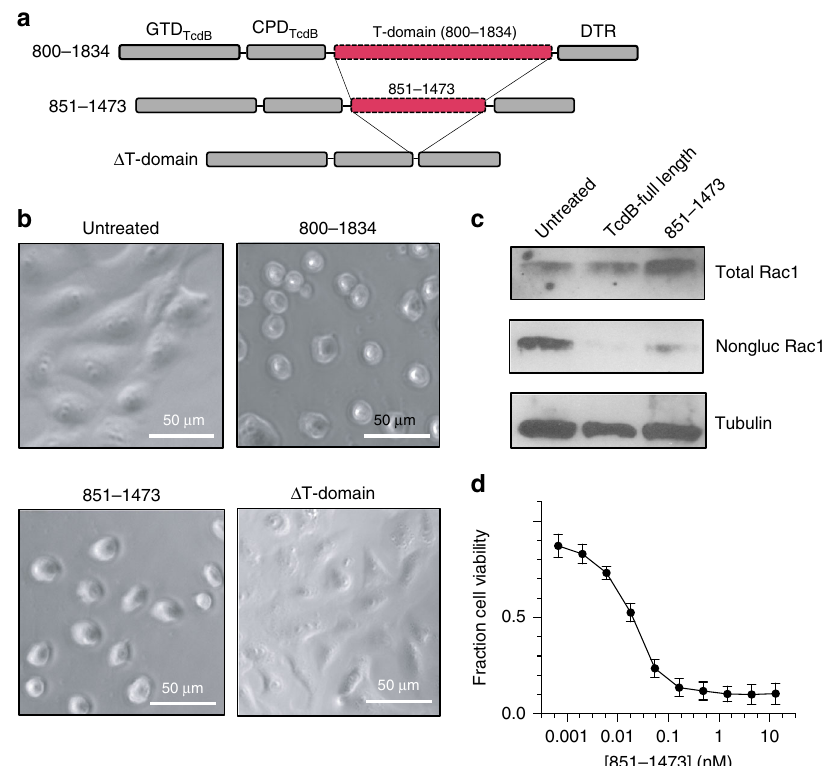
Fig. 6 TcdB 851-1473 functions as a translocase in a hybrid TcdB-DT context. a Construct design of GTD-CPD-[TcdB(800 – 1834)]-DTR (800 – 1834), GTD-CPD-[TcdB(851 – 1473)]-DTR (851 – 1473) and GTD-CPD-DTR ( Δ T-domain). b Light microscopy images of Vero cells with no toxin (untreated), 800 – 1834, 851 – 1473 or Δ T-domain after 3 h. All proteins were added to cells at a fi nal concentration of 1 nM. c Western blot to detect total Rac1, non- glucosylated Rac1 in untreated Vero cells, and in cells treated with TcdB or 851 – 1473. All proteins were added to cells at a fi nal concentration of 1 nM. d Fraction cell viability of Vero cells incubated with 851 – 1473, with 1.0 indicating 100% viable cells and 0 indicating 0% viable cells. N = 4 for all experiments. Source data are provided as a Source Data File for Fig. LCT-T homologs correlating domains and metagenomic abundance . AnnoTree was used for phylogenomic visualization of species containing LCT-T homologs across the bacterial tree of life 36 . Proteome-level Pfam annotations from the AnnoTree database were used to determine the domains most correlated with an annotated LCT pore-forming domain model (Pfam model PF12920), the top 100 of which are available in Supplementary Table 1. Metagenomic surveys were per- formed using EBI ’ s MGnify server (http://www.ebi.ac.uk/metagenomics) using the TcdB translocase (UniProt ID P18177.3, residues 800 – 1814) as the query.